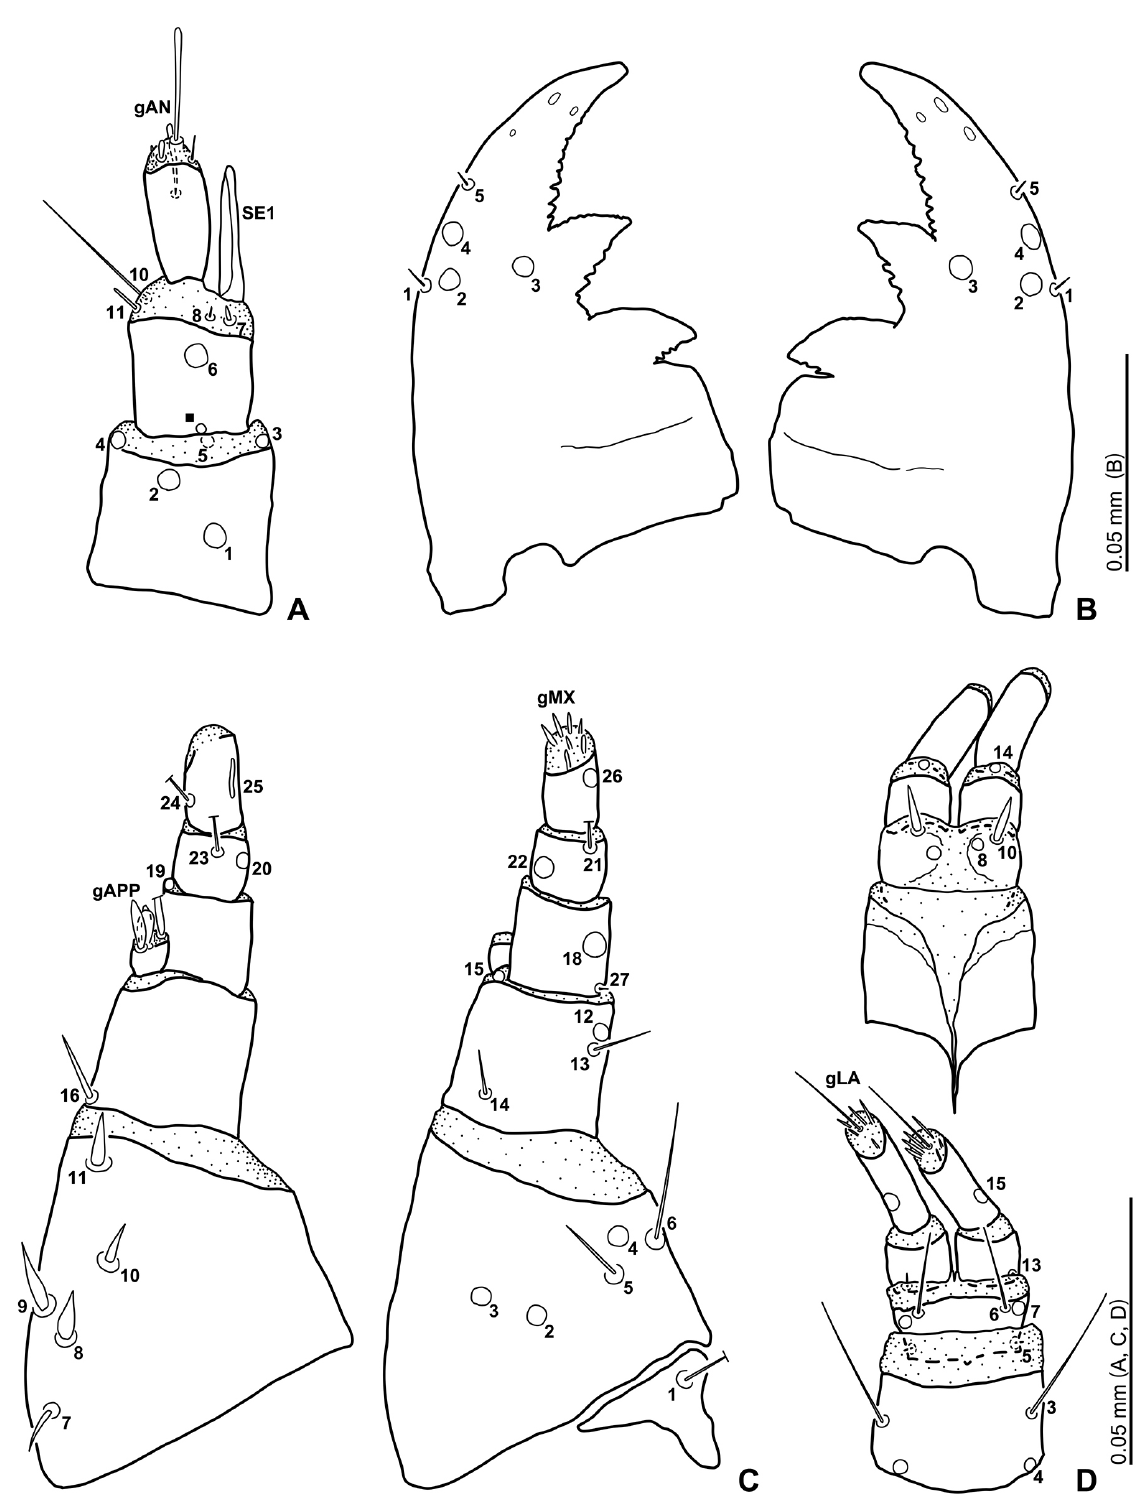
Figure 4. Larva of Psalitrus yamatensis Hoshina & Satô. A. Antenna, dorsal view; B. Mandibles, dorsal view; C. Maxilla, dorsal (left) and ventral (right) view; D. Labium (excluding prementum), dorsal (top) and ventral